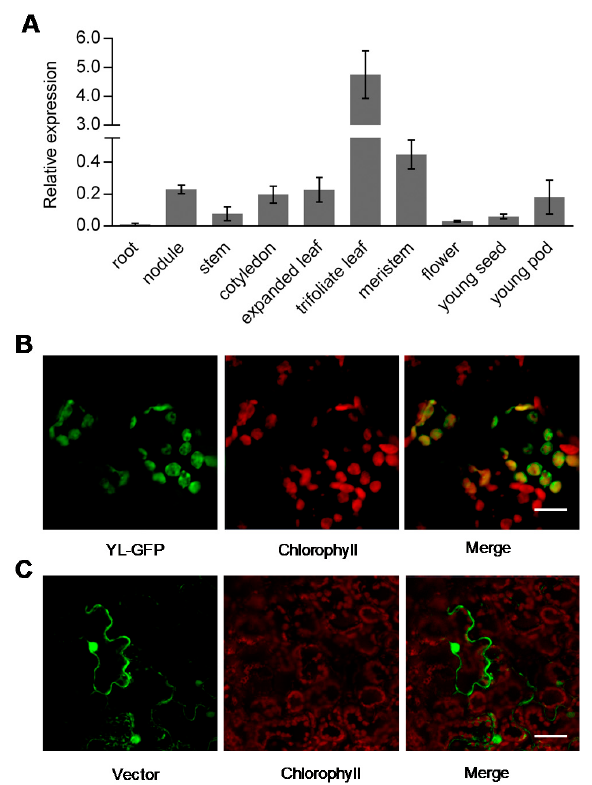
Figure 5. Expression pattern and subcellular localization of YL . ( A ) Relative expression levels of the YL gene in various soybean tissues. The real-time RT-PCR assays were performed in three biological replicates. qRT – PCR values for YL are normalized with the actin and ATP synthase genes. Error bars represent the SD. ( B , C ) Subcellular localization of the YL-GFP fusion protein (B) and GFP (C) in epidermal cells of Nicotiana benthamiana leaves. Bar = 20 μ m in (B) and 50 μ m in (C). 2.5. Dramatic Defects of Chloroplast RNA Editing in yl To further understand the function of YL , we performed DNA resequencing and RNA sequencing (RNA-seq) for the wild type to screen out soybean chloroplast editing sites, obtaining 44 predicted sites from 22 chloroplast transcripts (Tables 2, S1, S2). In addition, the rpl23 -89 site was identified through comparative analyses with Arabidopsis chloroplast editing sites (Table 2). Most of these sites were verified by direct sequencing of PCR products of transcripts or the corresponding genomic DNA carrying them (Table S2). Among the 45 editing sites, 44 sites were C-to-U conversions, 43 sites were in the coding regions of genes, and most of them caused alteration of the encoded amino acids (Table 2). Table 2. RNA editing sites in soybean chloroplast transcripts. Gene